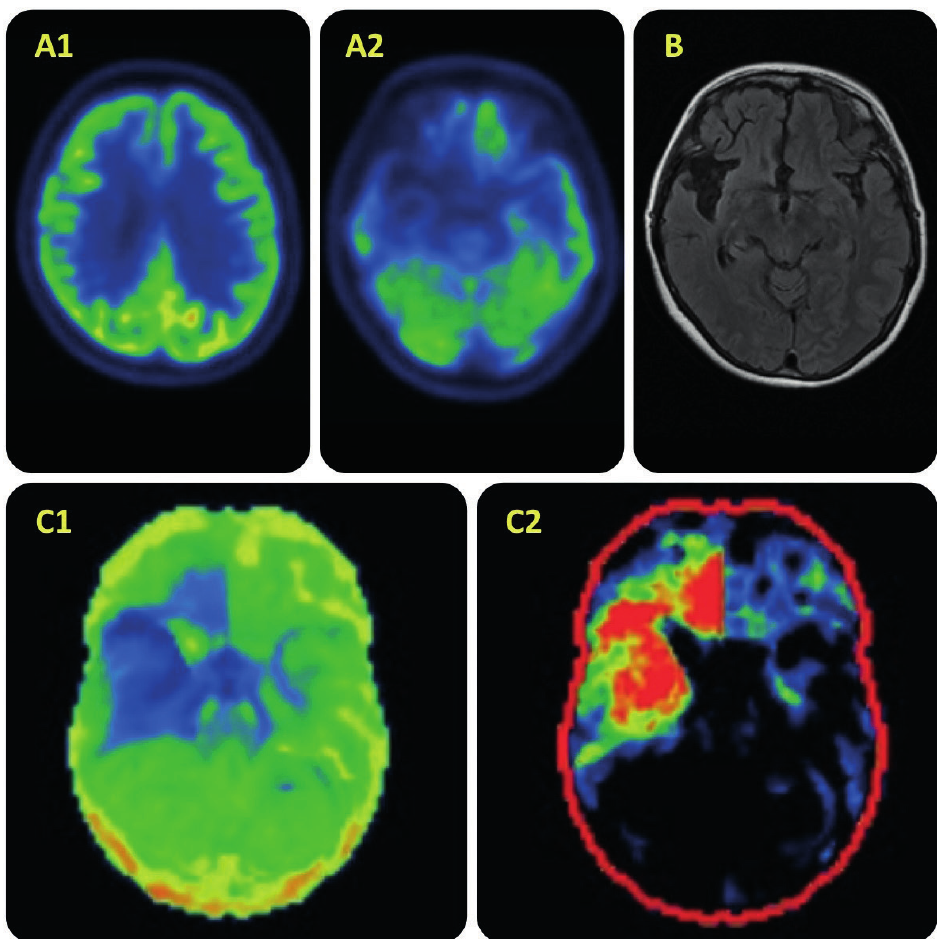
Figure. Upper row – A1, A2: [18F]FDG-PET transaxial images showing prominent hypometabolism in the right temporal lobe and, to a lesser degree, in the right frontal and parietal lobes, particularly orbitofrontal areas. B – transaxial T2 FLAIR MRI image showing selective right temporal atrophy. Lower row – C1: a 3D-SSP reconstruction (inferior view) showing prominent hypometabolism in the right temporal lobe and right orbitofrontal cortex. C2 – 3D-SSP projection of comparison with a group of healthy age-matched individuals. Red areas indicate areas of lower metabolism than expected 423x423mm (72 x 72